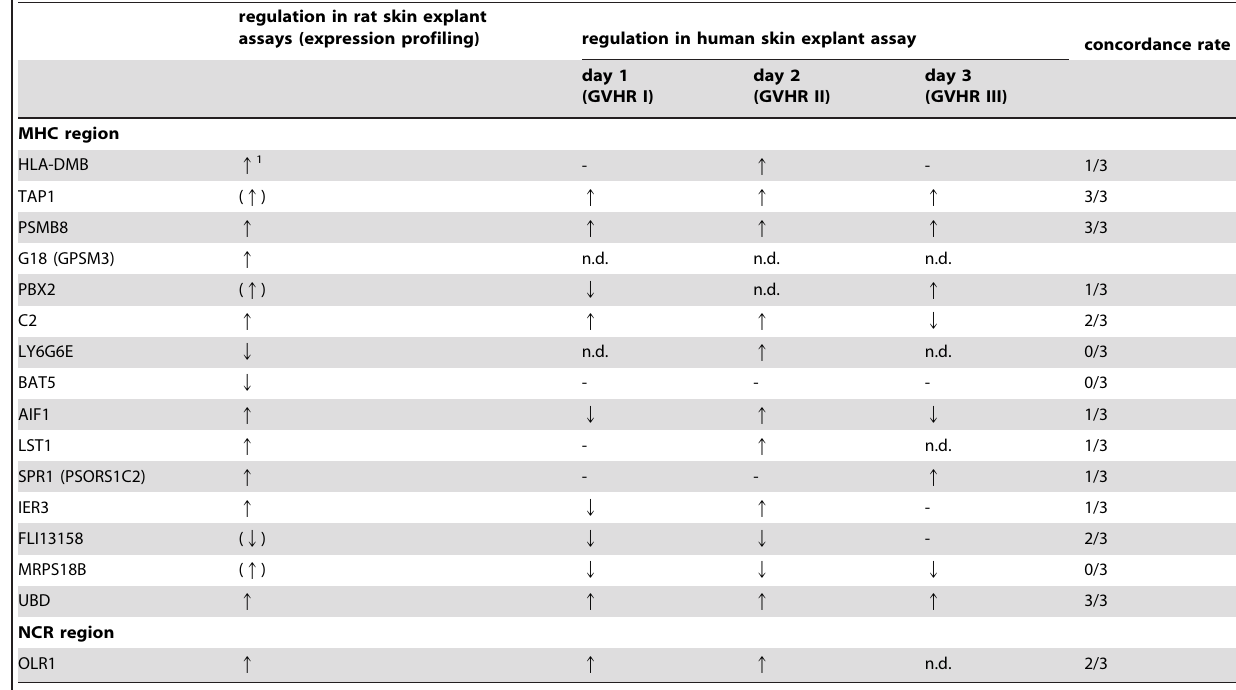
1 Explanation of symbols: q up-regulated mRNA expression level (log2-fold change $